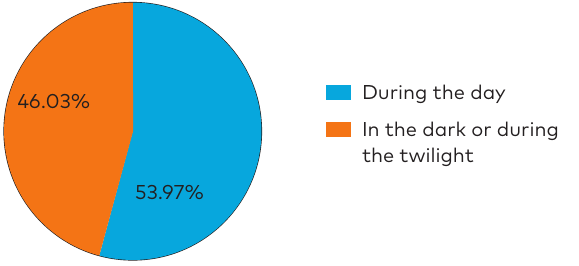
Figure 6. Pedestrian collisions in three largest Lithuanian cities